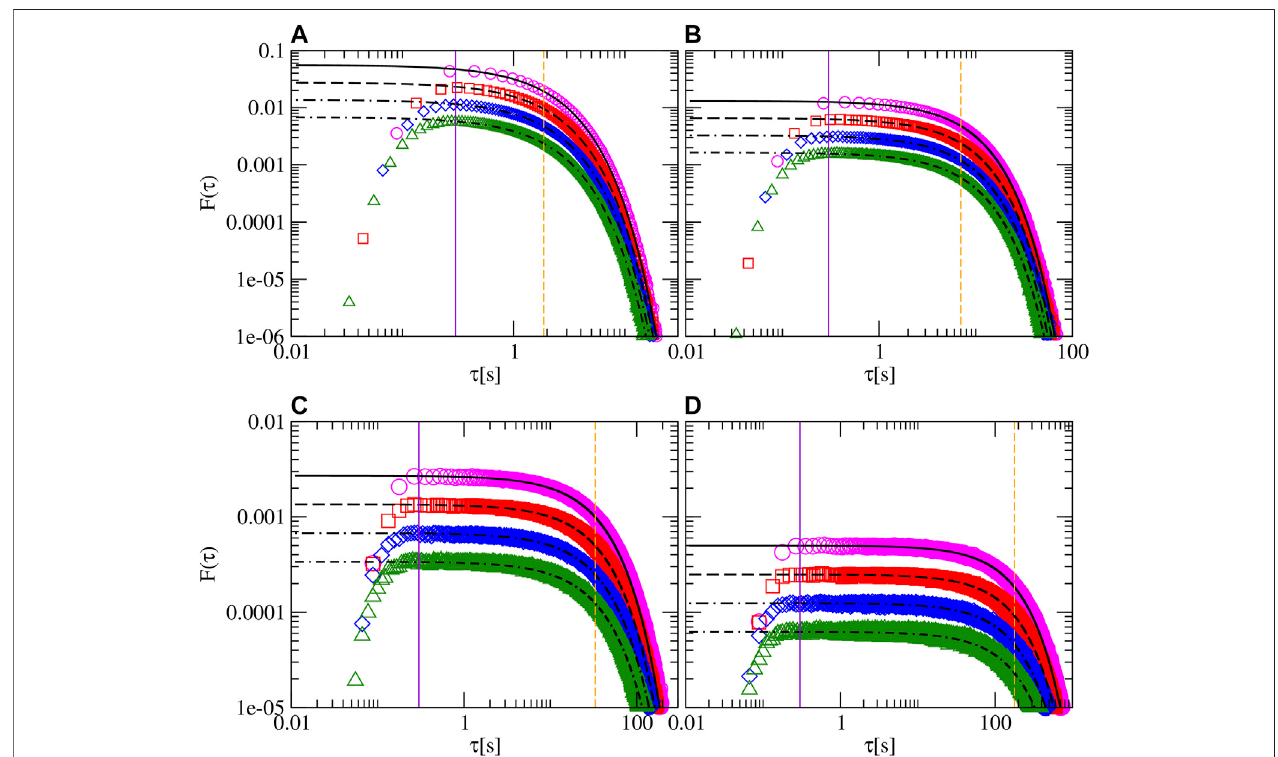
FIGURE11| (Coloronline):Browniandynamicshistogramsofthe fi rstpassagetime(FPT) τ fordifferentbarrierheights U 0 and Δ t bins.Thevalueof U 0 in k B T unitsis 1, 2,3,and4for (A – D) ,respectively.The Δ t bin is0.08, 0.04,0.02, and0.01 sforpink circles,red squares,blue diamonds,andgreentriangles,respectively.Blacklines are exponential tail fi ttings associated to Eq. 20 . For a given U 0 value, the vertical purple solid line corresponds to the critical time t * , and the vertical orange dashed line indicates the mean fi rst passage time τ MFPT . The periodicity of the fringe and the short times diffusion coef fi cient are L (cid:2) 1 . 0 × 10 − 6 m